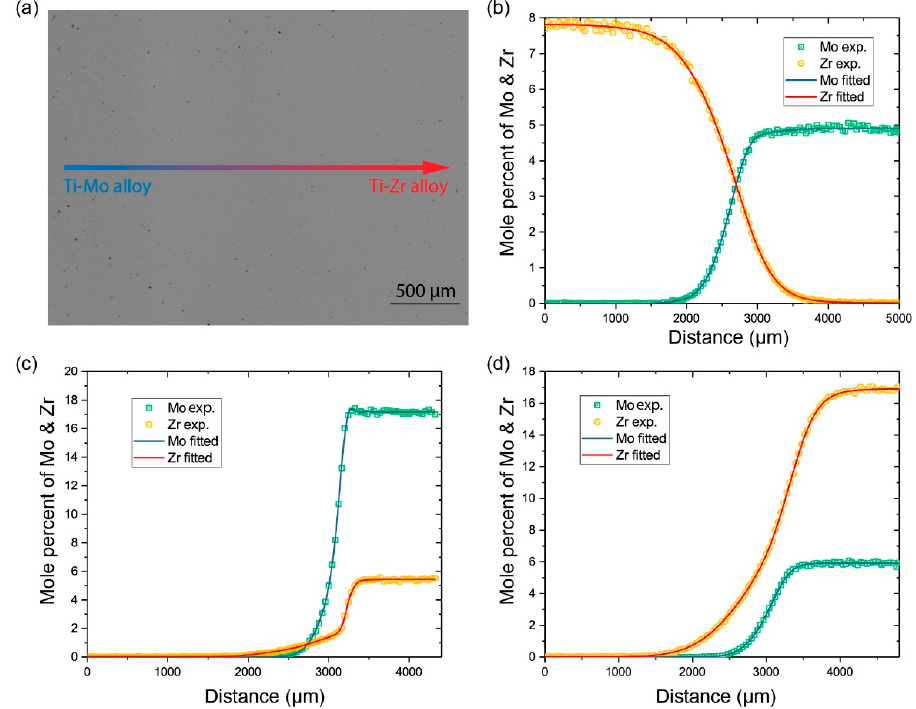
Figure 2. ( a ) Microstructure (BSE) of the diffusion couple M1 annealed at 1373 K for 72 h and the robust error function expansion (ERFEX) representation of the composition-distance profiles of the different couples annealed in 1373 K for 72 h: ( b ) for M2; ( c ) for M6; ( d ) for M8.